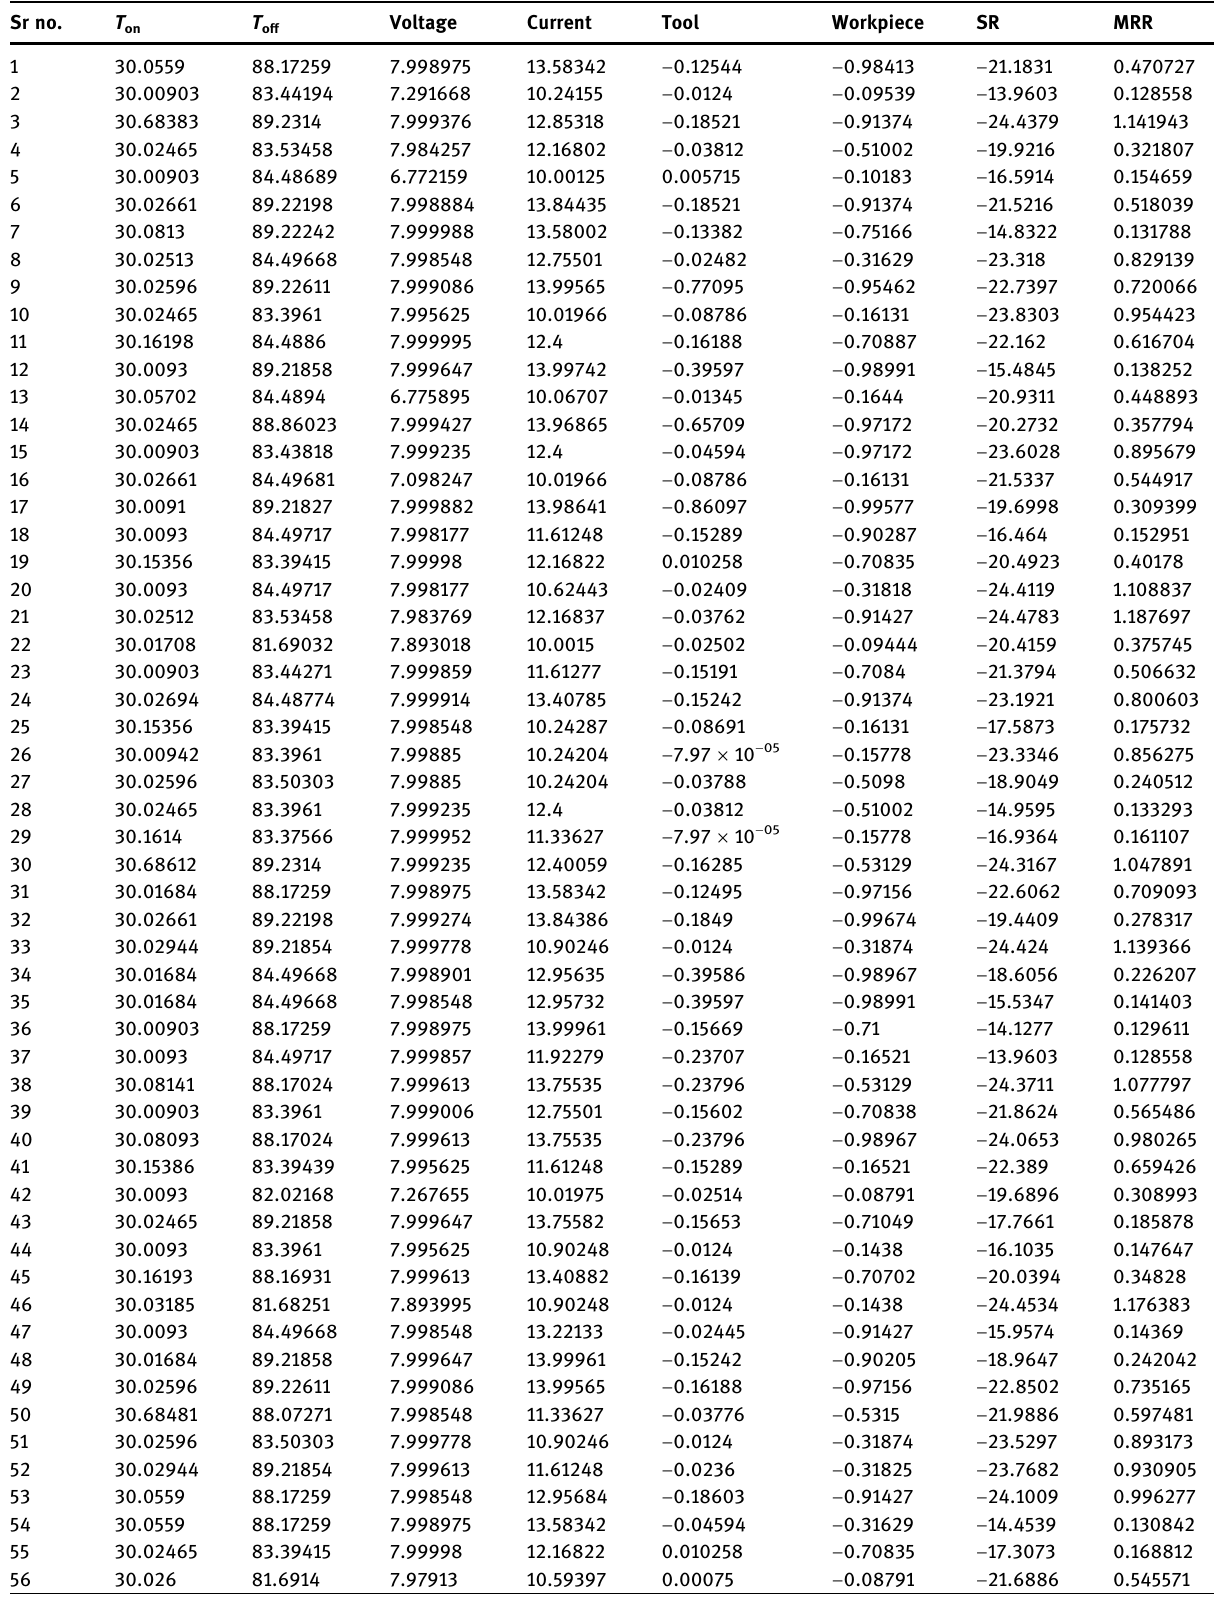
Table 7: Solution set suggested by NSGA - II Sr